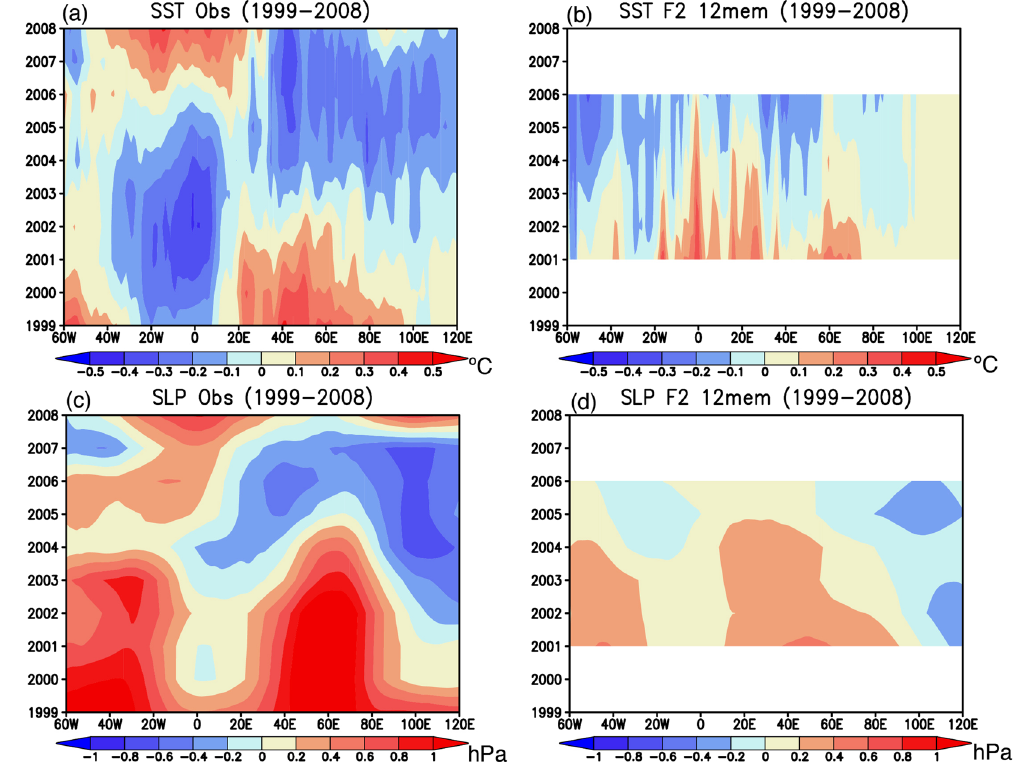
Figure 8. ( a ) Time-longitude section of 5-yr running mean SST anomalies (in °C) averaged in the longitudinal band of 40–50°S during 1999–2008. ( b ) Same as in ( a ), but for the reforecast experiments initialized from March 1st 1999. 12 ensemble mean results are used. ( c , d ) Same as in ( a , b ), but for the SLP anomalies (in hPa). The maps were generated using Grid Analysis and Display System (GrADS) Version 2.1.a3 (http://cola.gmu.